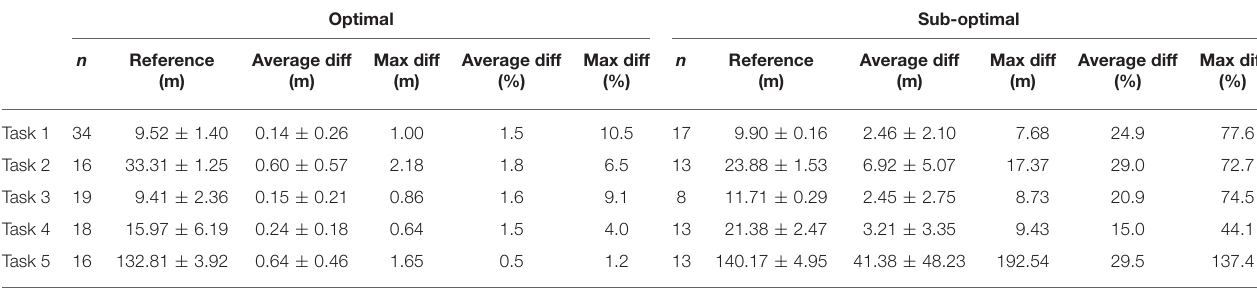
TABLE 2 | Difference between the LPS and reference system for distance traveled, for optimal and sub-optimal condition respectively.